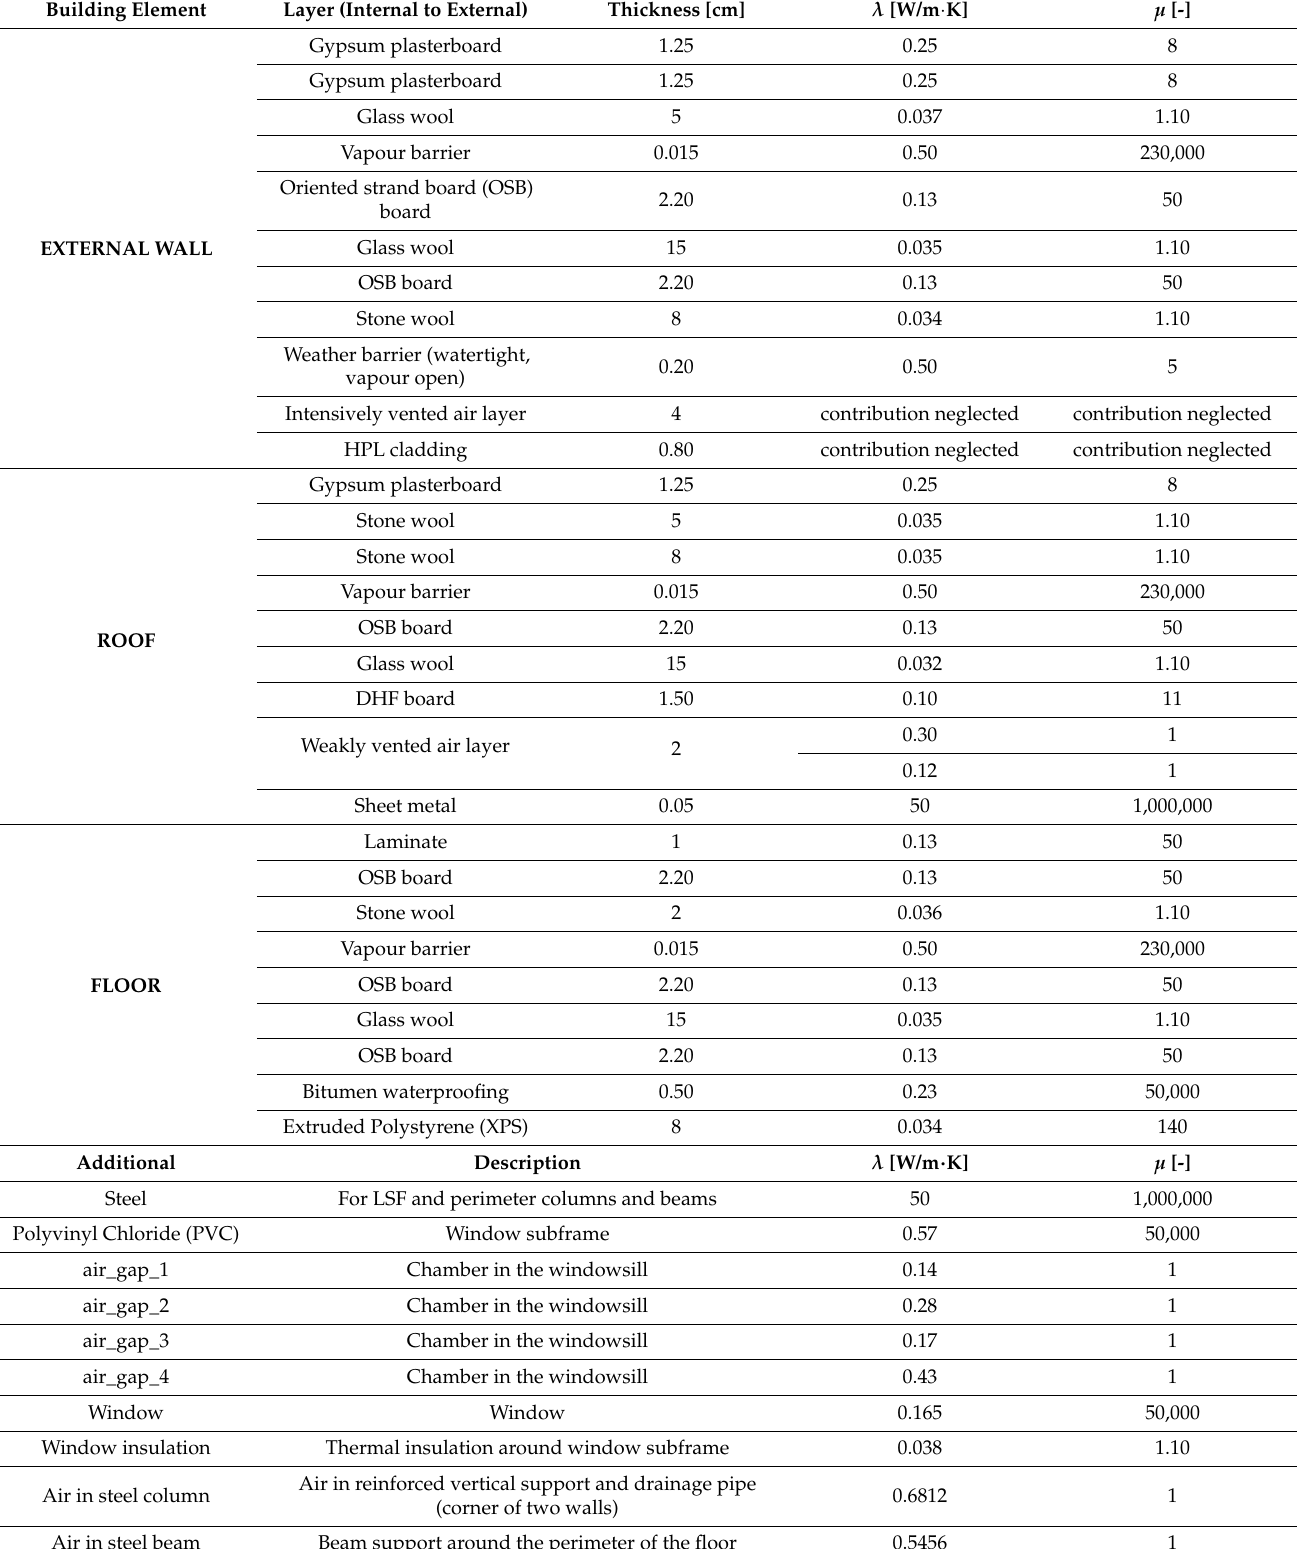
Table 2. Building envelope assemblies—material thickness and basic hygrothermal